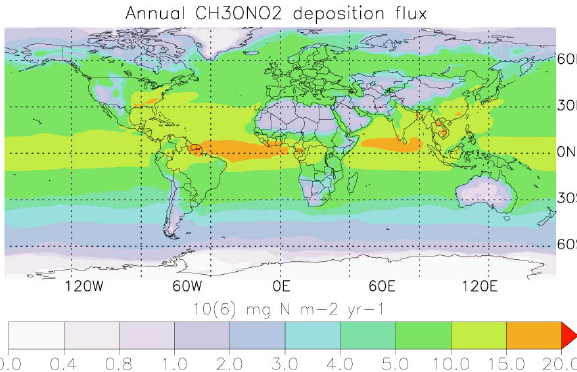
Fig. 2. The annually integrated global deposition flux of CH 3 ONO 2 during 2008 from FULL. The values are given in 10 6 mgNm − 2 yr − 1 .